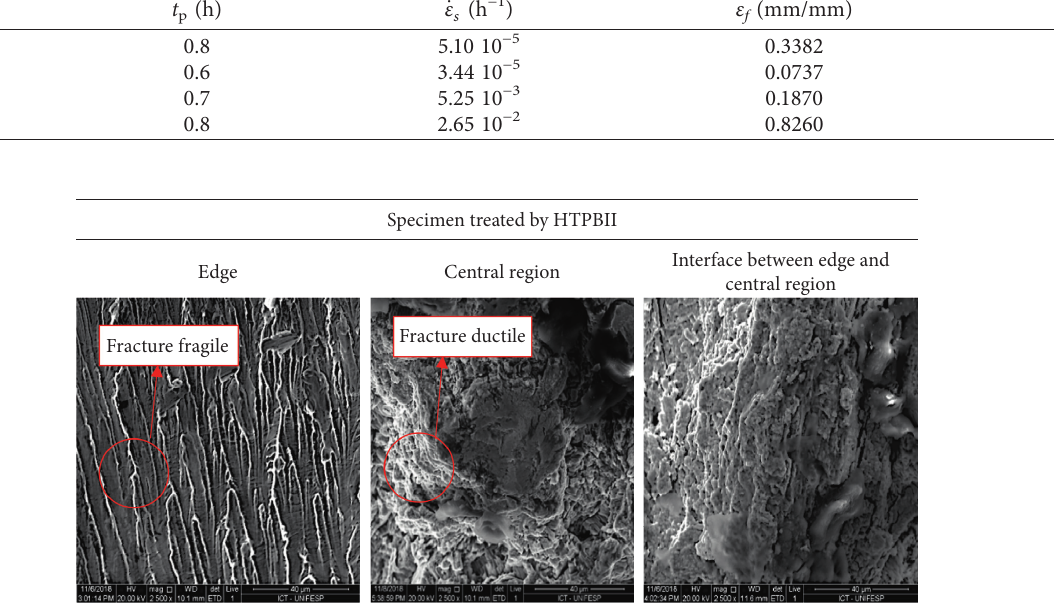
Figure 8: SEM micrograph of the fracture surface of a specimen treated for 1 h after creep tests at 500 ° C and 35